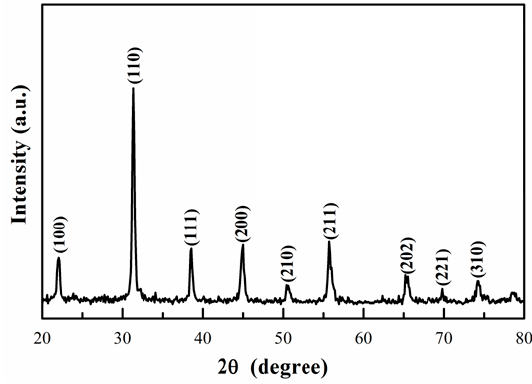
Figure 1. The X-ray diffraction pattern of BaTiO 3 nanofibers. Figure 1. The X ‐ ray diffraction pattern of BaTiO 3 nanofibers . Figure 1. The X ‐ ray diffraction pattern of BaTiO 3 nanofibers .